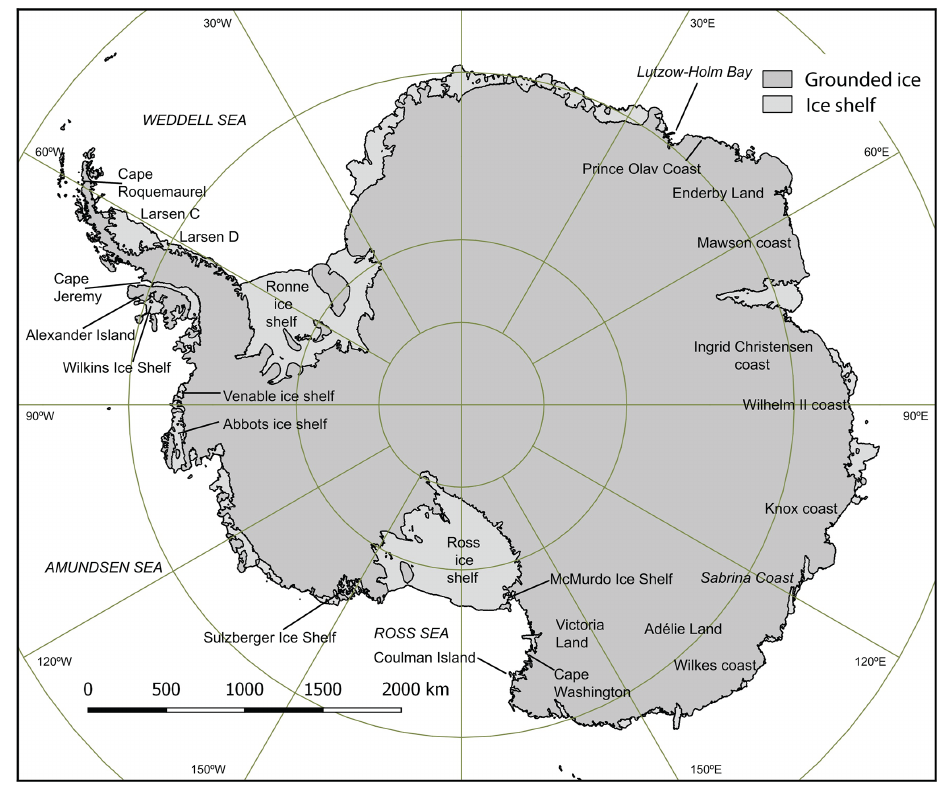
Figure 1. Map of the vector coastline derived from the MODIS Mosaic of Antarctica dataset (Scambos et al., 2007) showing the coastline, the distribution of ice shelves, and (inland) the grounded ice coastline. Offshore islands were excluded for this study. Inclusion of islands is complex and application-specific and thus will be considered in future detailed case studies of specific areas. Reproduced with